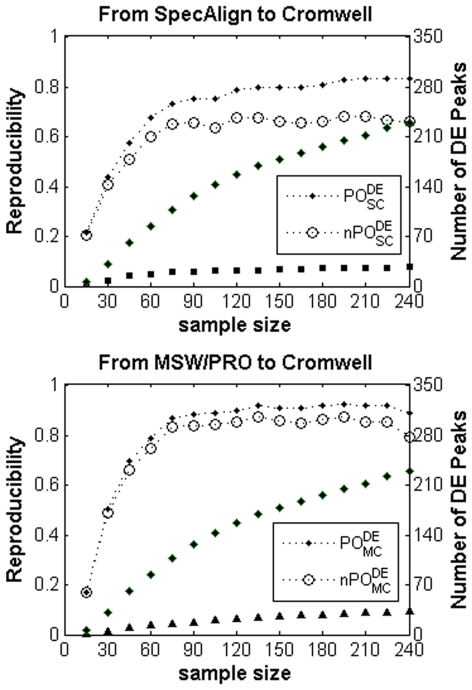
Average number of DE peaks and average PODE (nPODE) score at various sample sizes for prostate cancer.The default SNR was used for each pre-processing algorithm. At each sample size, the average number of DE peaks detected at a 10% FDR control was calculated based on 100 randomly sampled subsets. The filled squares, triangles and diamonds represent the average number of DE peaks (right y-axis) detected using SpecAlign, MSW/PRO and Cromwell, respectively.